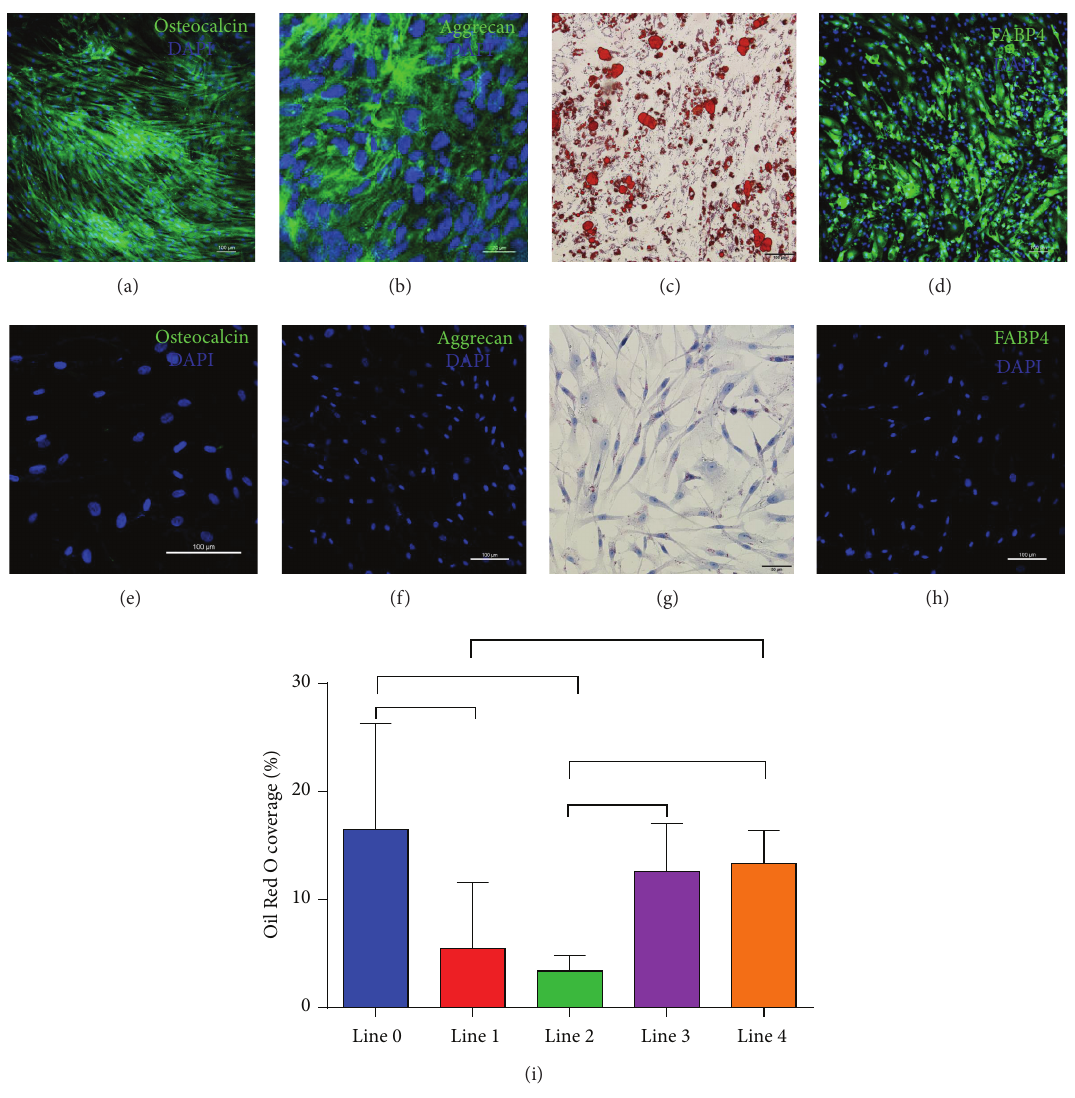
Figure 3: Trilineage differentiation of neonatal sbMSCs. Sternal MSCs ( 𝑛 = 4 lines) were incubated with differentiation media for 14–21 days. (a) Osteogenic differentiation was demonstrated by anti-osteocalcin staining. (b) Chondrogenic differentiation by anti-aggrecan staining. (c and d) Adipogenic differentiation was demonstrated by Oil Red O and anti-FABP. (e–h) Neonatal sbMSCs cultured in standard growth media did not demonstrate any spontaneous differentiation. (i) Varying efficiency of adipogenic differentiation of sbMSCs by Oil Red O staining as quantified by image analysis. Data were analyzed by one-way ANOVA with post hoc Tukey test and significant differences ( 𝑝 < 0.05 ) are indicated with